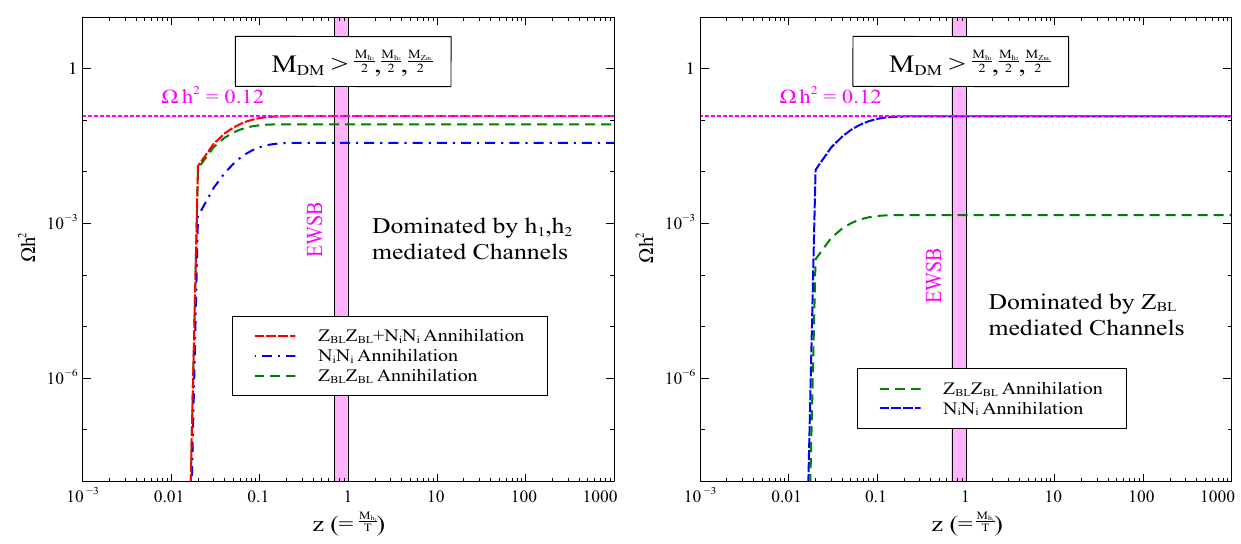
Fig. 15 Left (Right) Panel: Variation of the DM relic density (cid:9) h 2 with z when dominant contributions are coming from scalar h i (gauge boson Z BL ) mediated annihilation channels. The other relevant parameter val- ues have been kept fixed at λ Dh = 7 . 017 × 10 − 12 (7 . 212 × 10 − 13 ),